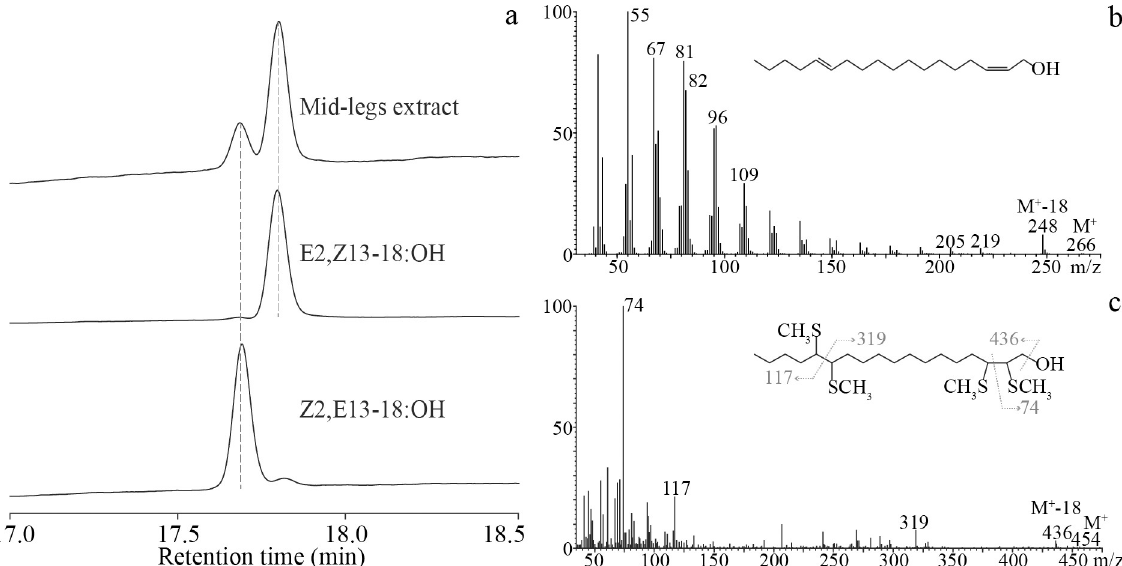
Fig 5. Configuration assignment of 2,13-octadecadienol in the midlegs of male Telchin licus . (a) Chromatograms of the midleg extract of male T . licus , Z2,E13-18:OH and E2,Z13-18:OH. GC-FID equipped with an Rtx-Wax capillary column. (b) Mass spectra (EI) of ( Z , E )/( E , Z ) 2,13-octadecadienol in male midlegs and (c) corresponding DMDS adducts. Each spectrum shows diagnostic fragment ions, and the adducts show the fragment ions produced by cleavage of the bond between the sulfur-substituted carbons, indicating positions 2 and 13 of the double bonds. GC-MS equipped with an Rtx-5 capillary column.